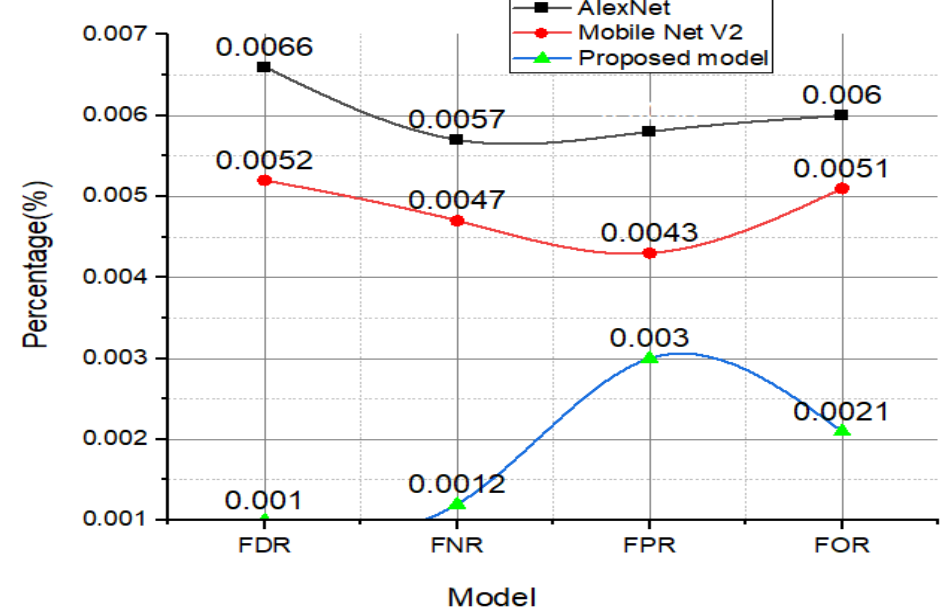
Figure 10. The attained values of the FDR, FNR, FPR, and FOR of the proposed model and the other TL models.